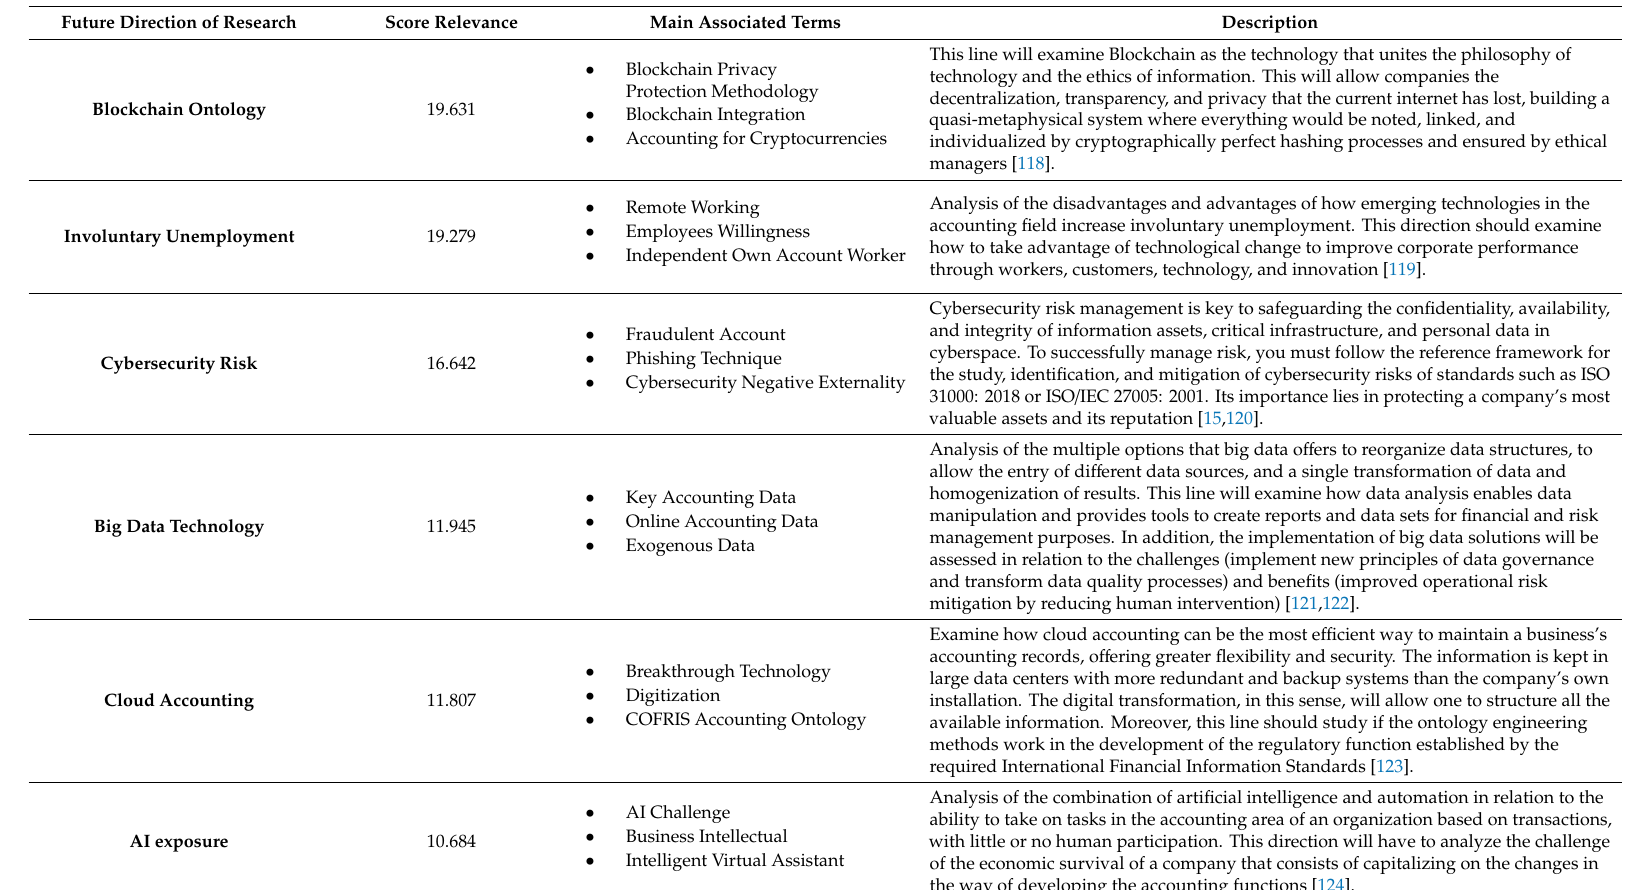
Table 6. Future directions of research based on score